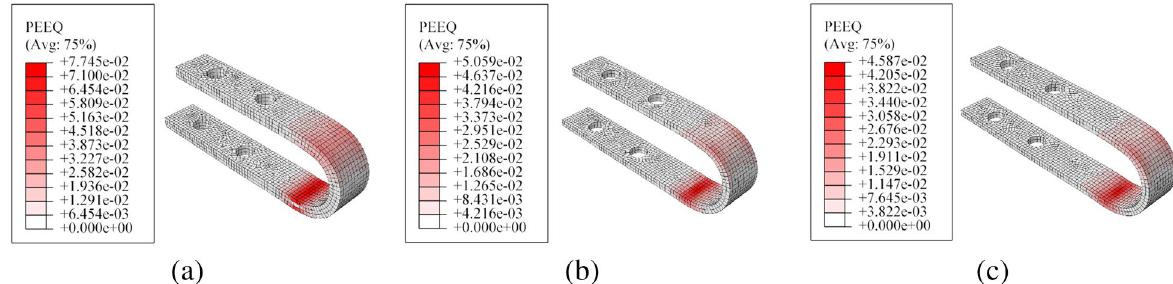
Fig. 10 Contour of the equivalent plastic strain of USSs of a 19–6‑35 series, R/t 15 mm in‑plane displacement